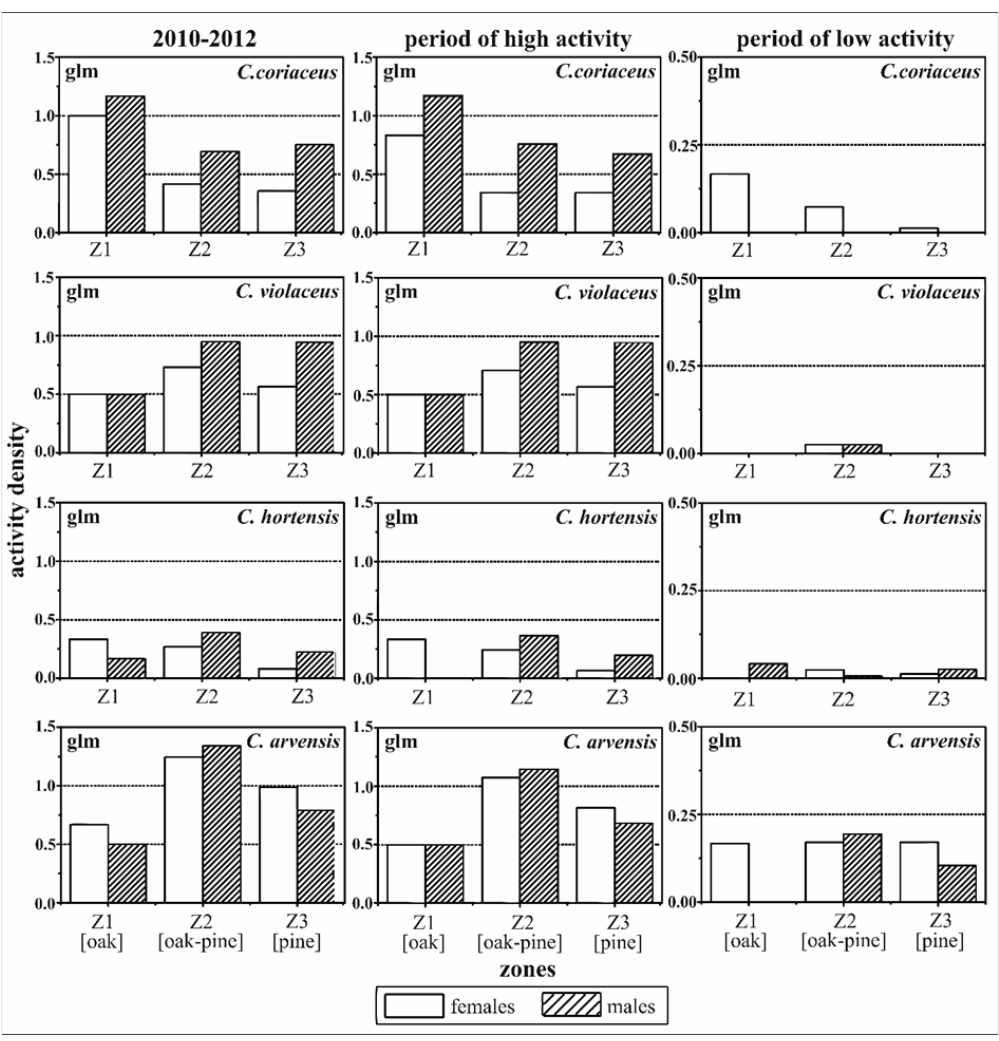
Figure 3. Zone-related activity densities of C. coriaceus , C. violaceus , C. hortensis and C. arvensis differentiated by sex (females versus males). Females and the pine zone were used as the reference for the model calculation. The results of the generalised linear models (glm) address effects of zoning and sex simultaneously for different activity periods (high activity period: May to September, low activity period: October to April); Z1—oak zone, Z2—oak–pine zone, Z3—pine zone. Table 2. Parameters of the generalised linear model (glm) for intraspecific comparisons taking into account the three zones of influence and sex, and differentiated by periods of activity. (The levels of